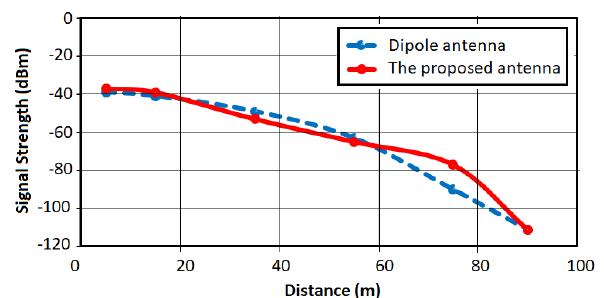
FIGURE 18 . The signal strength comparison of the proposed antenna and the dipole